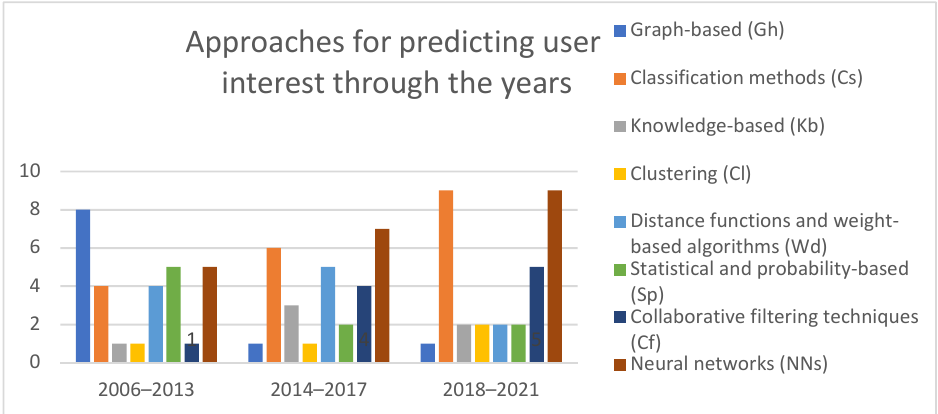
Figure 5. Approaches used for predicting user interest towards ads.